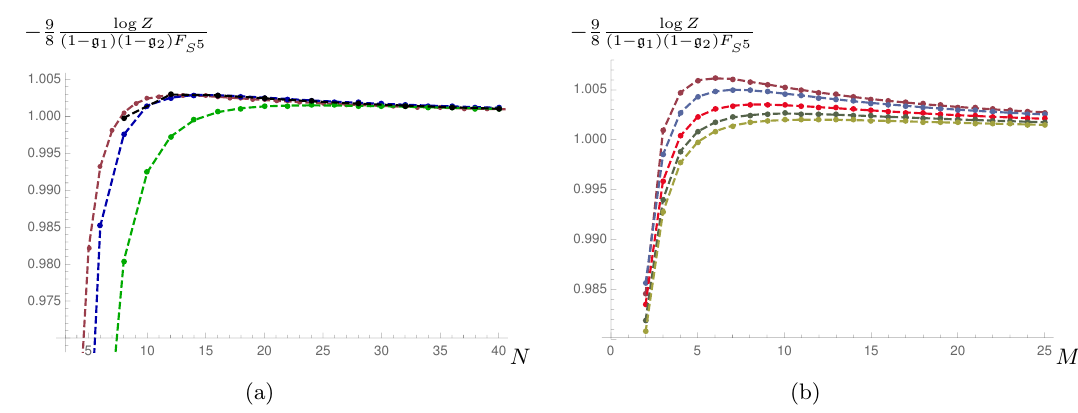
Figure 3 . Ratio of the topologically twisted index and the (cid:12)ve-sphere partition function, evaluated numerically as described in section 2.3. On the left hand side for the T N (red), T T (green) and T (black) theories. On the right hand side for # N;M as functions of N;N= 2 ; 2 N;N= 4 ; 3 M . From top to bottom the curves are N 2 f 5 ; 10 ; 15 ; 20 ; 25 g . As function of N the ratio exhibits similar convergence